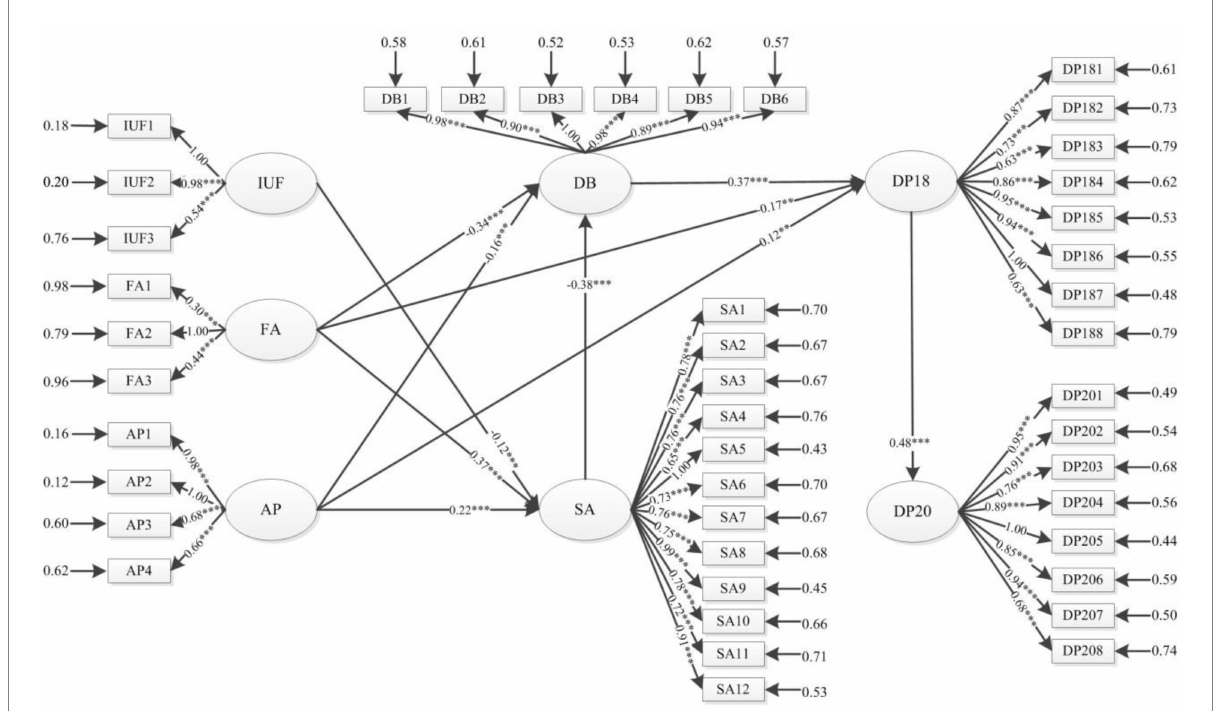
FIGURE 3 A Chain-mediated model of Self-adjustment and Campus Deviant Behavior on Adolescent Depression. IUF, Internet use Frequency; FA, Family Atmosphere; AP, Academic Performance; SA, Self-adjustment; DB, Deviant Behavior; DP18, Depression in 2017–2018; DP20, Depression in 2019– 2020; 2019–2020; ** p < 0.01, *** p < 0.001.